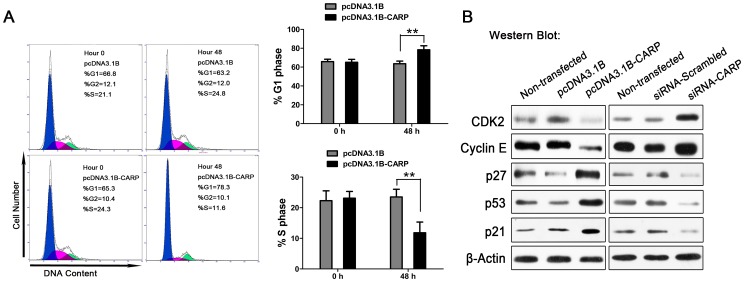
CARP caused G1 arrest and modulated the key cell-cycle regulators in BGC-823 cell.(A) CARP caused G1 phase arrest 48 hours later. (B) Western blot analysis of cyclin E, CDK2, p27, p53 and p21 expression 48 hours after seeding of stably transfected cells or transfection of siRNA (n = 5, *P<0.05, **P<0.01).